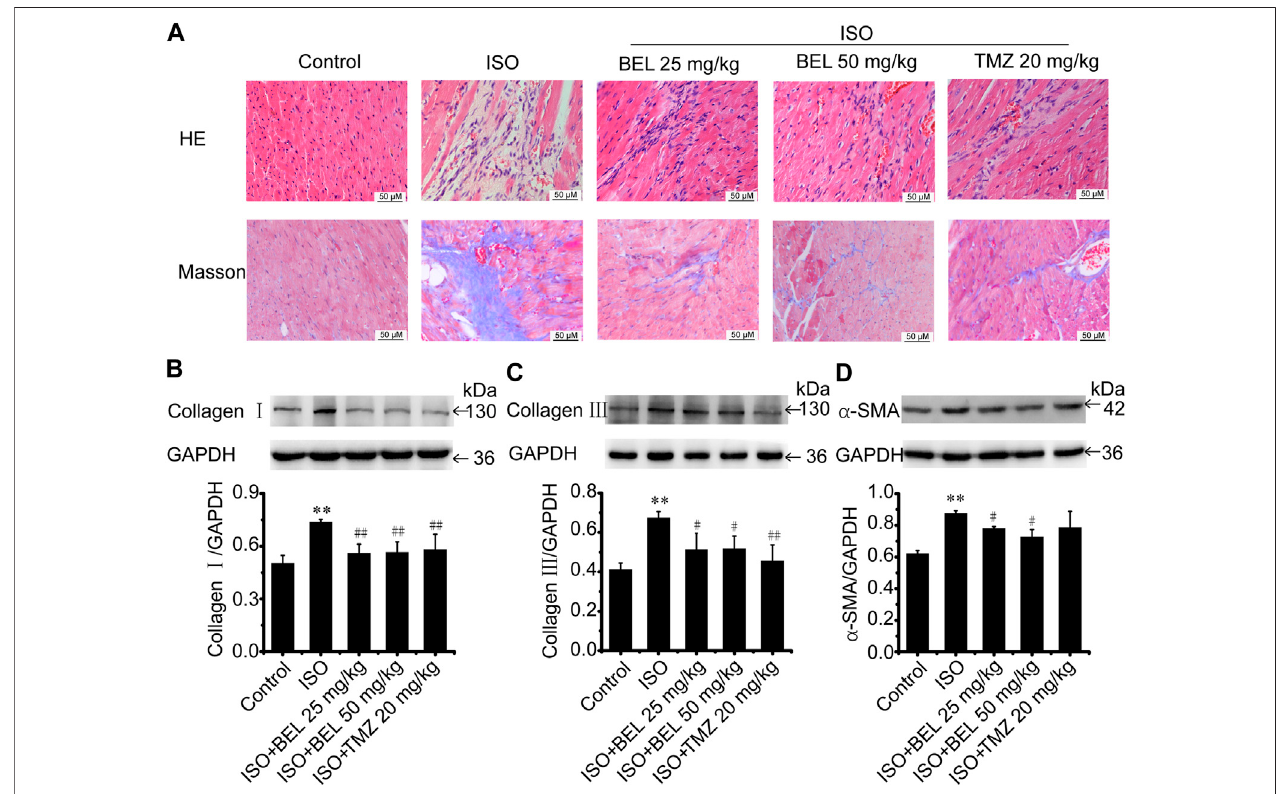
FIGURE2| BELamelioratesISO-inducedmousemyocardial fi brosis (A) HEstainingtodetectmorphologicalchanges;Massontrichromestainingtodetectcardiac collagen deposition (B – D) Western blotting detection of collagen Ⅰ , collagen Ⅲ , and α -smooth muscle actin ( α -SMA). Bar graphs show fold changes for the collagen Ⅰ , collagen Ⅲ , and α -SMA expression as analyzed by western blotting. Glyceraldehyde 3-phosphate dehydrogenase (GAPDH) was used as a loading control ( n (cid:2) 3). Data were shown as mean ± SEM. ** p < 0.01 vs. control, # p < 0.05 vs. ISO, ## p < 0.01 vs. ISO.